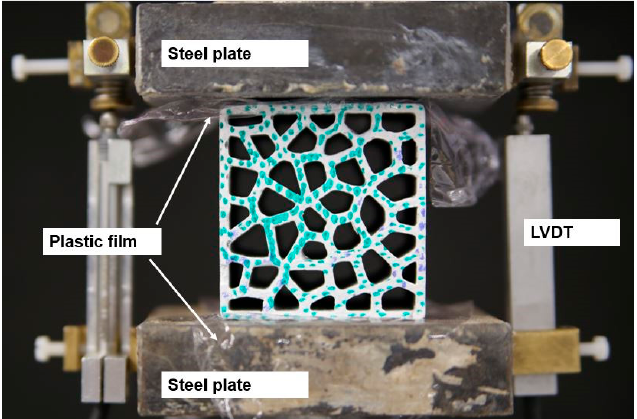
Figure 10. In-plane uniaxial compression test set-up on INSTRON 8872.